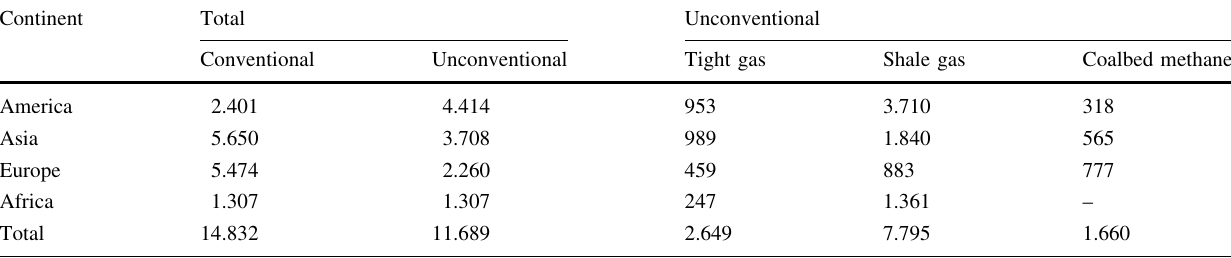
Table 1 The status of technically recoverable gas reserves around the world Reproduced with permission from EIA 2013 Continent